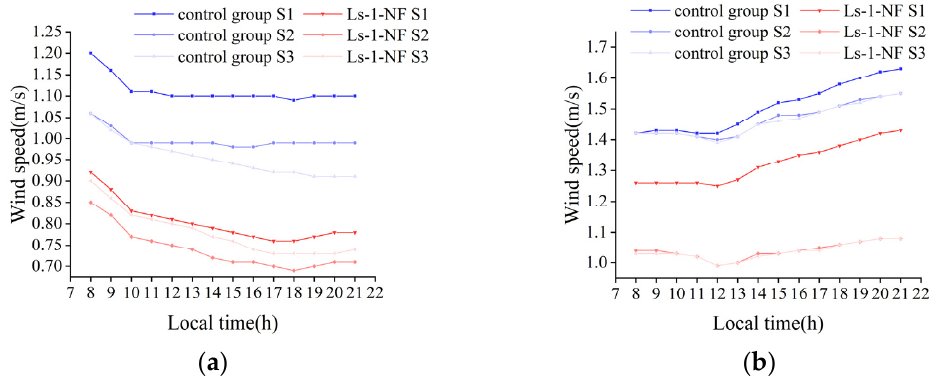
( b ) Figure 16. Effects of planting arbors on air temperature in different walking spaces in summer ( a ) and winter ( b ). Figure 17 shows the difference in the effects of arbors on the wind speed of different walking spaces. In the control, the wind speed of walking space S1 was significantly